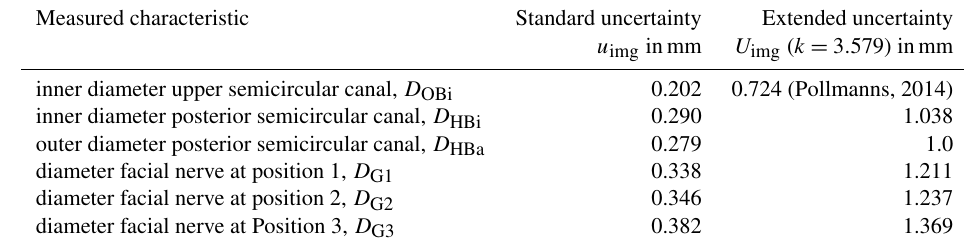
Table 3. Expanded uncertainties of the measuring method for different measuring